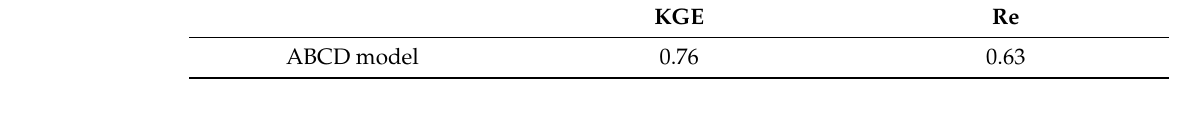
Table A5. Calibration performance indices for the KRB.